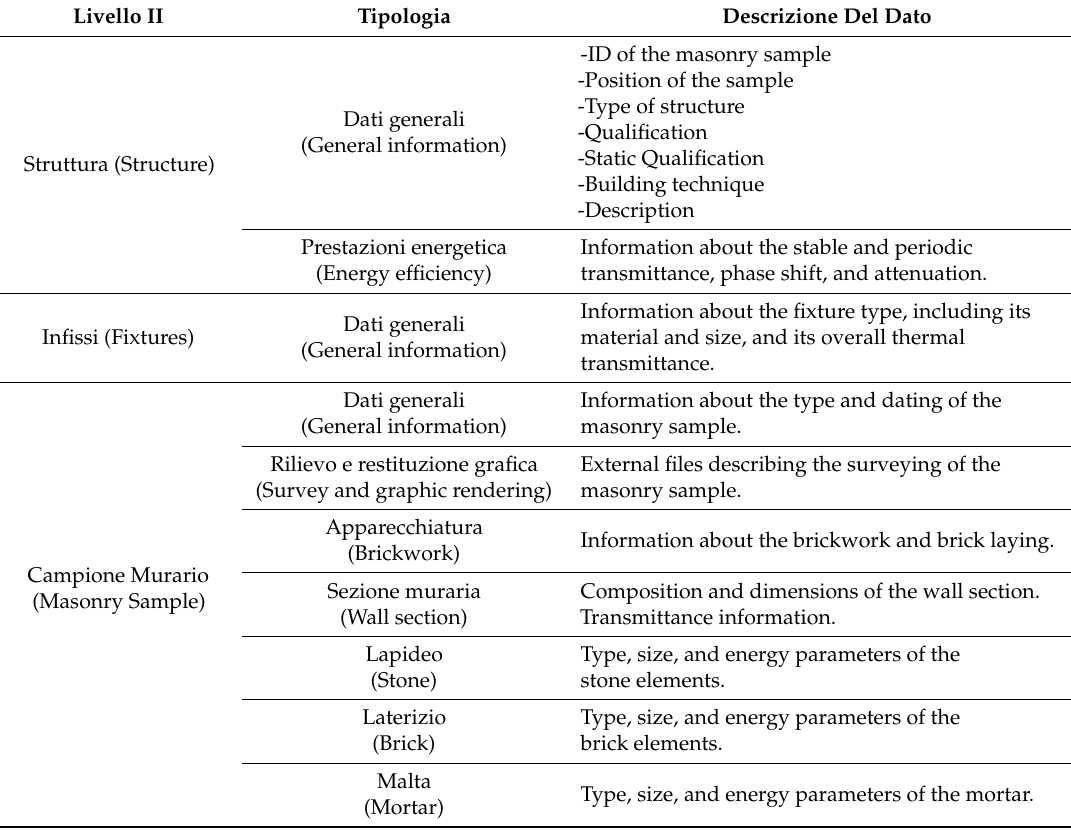
Table 2. Structure, Fixture, and Masonry Sample